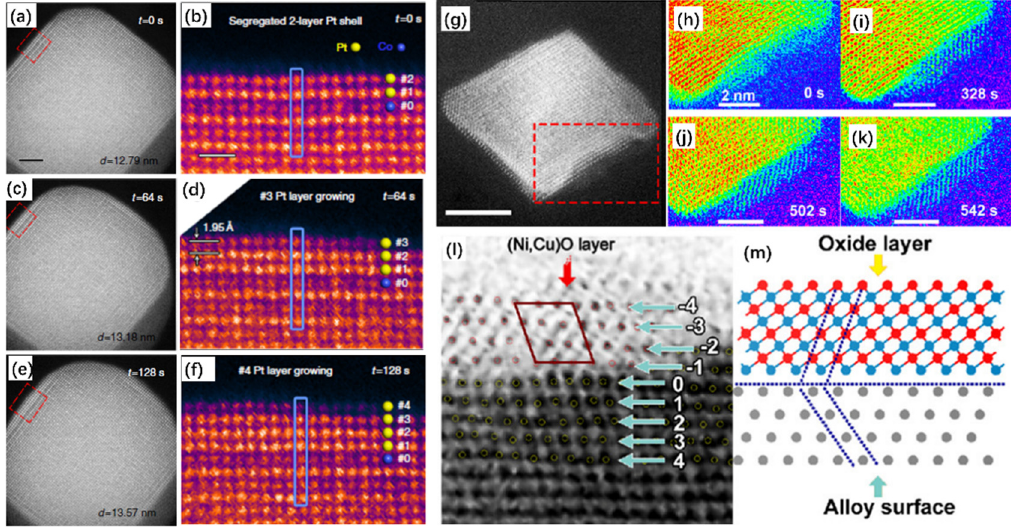
Figure 3. ( a – f ) Evolution of one (001) Pt shell during oxygen annealing [53]. Sequential high-angle annular dark field (HAADF) images taken at ( a ) 0 s, ( c ) 64 s, and ( e ) 128 s. ( b , d , f ) Corresponding enlarged false-color panels of ( a , c , e ), respectively. Reproduced with permission from [53], Nature Publishing Group, 2017. ( g – m ), oxidation evolution during in situ experiment [61]: ( g ) is the HAADF image of an octahedral Pt 2 CuNi NP. ( h – k ) is the time series false-color BF-STEM images of an (111) facet marked in ( g ). ( l , m ) are enlarged BF-STEM and model schematic of the interface between the alloy and the oxide layer. Reproduced with permission from [61], ACS Publishing Group, 2019.